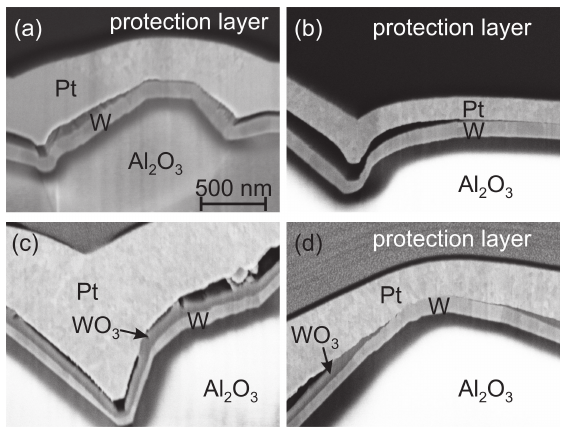
Figure 14. Cross-section images of a Pt ∗ /W/Al 2 O 3 sample in ( a ) the as-prepared state and after annealing ( b ) in forming gas and ( c ) in air at 400 ◦ C for 2 h; ( d ) sample annealed in air showing a position where no WO 3 has formed since there is no gap between the Pt ∗ and the barrier